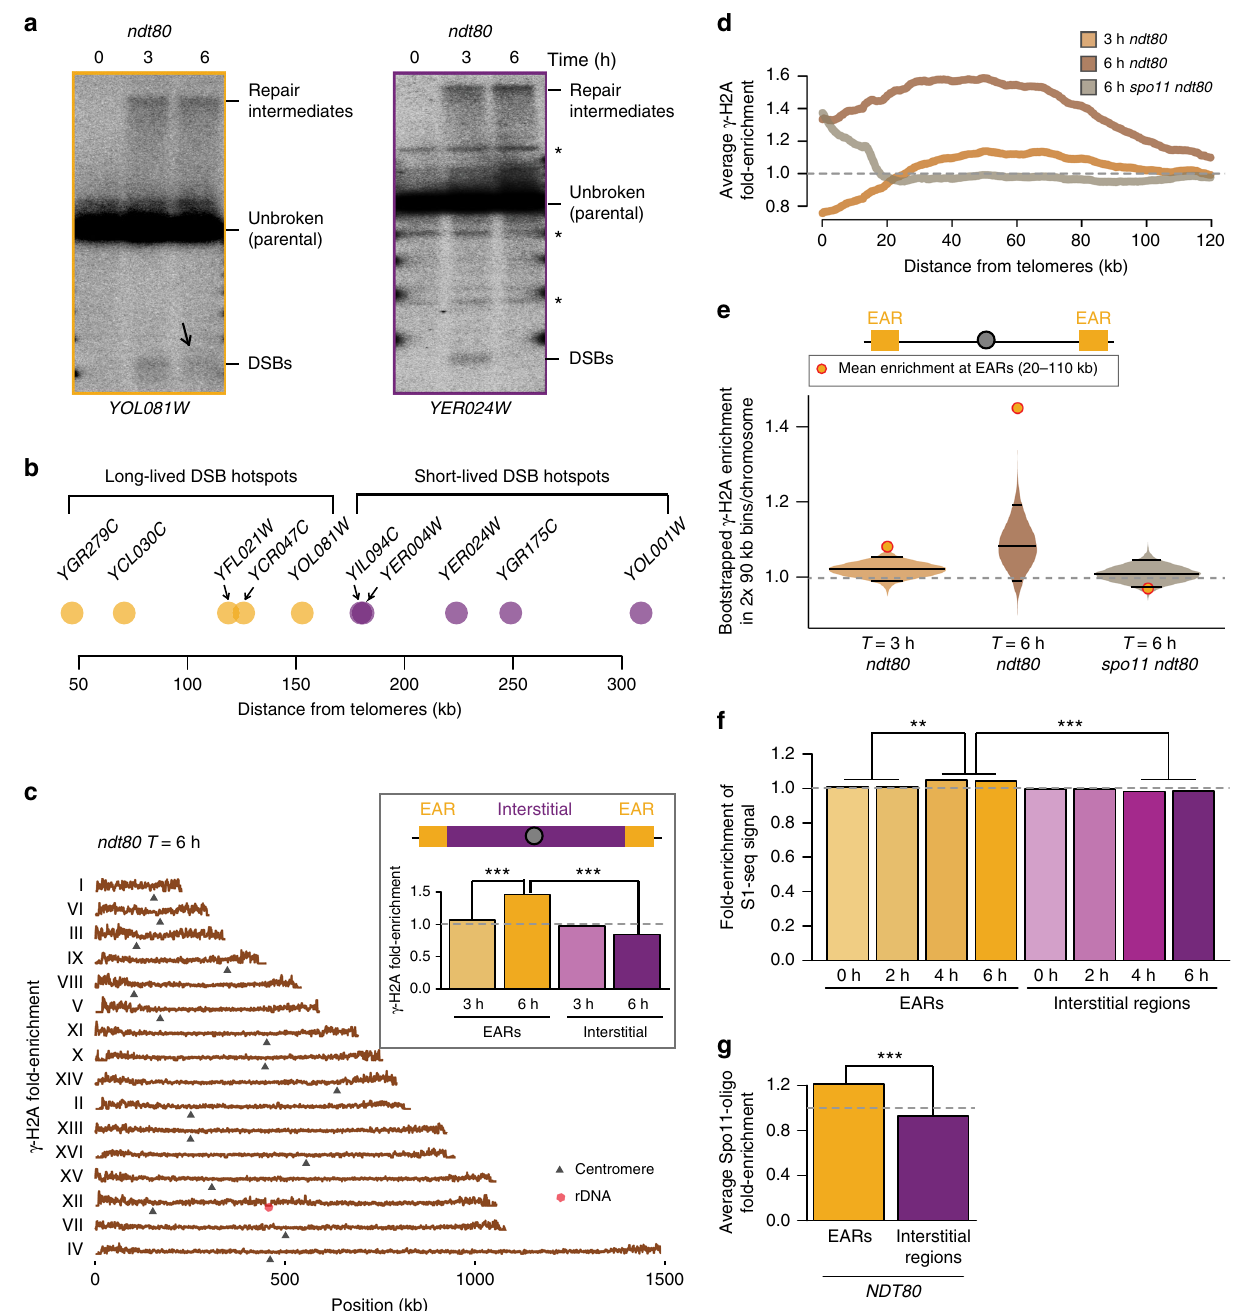
Fig. 1 Long-lived DSB hotspots occur primarily in EARs. a Southern analysis of DSBs from ndt80 Δ cells progressing synchronously though meiotic prophase at YOL081W (long-lived DSB hotspot, orange outline) and YER024W (short-lived DSB hotspot, magenta outline). Black arrow highlights continued DSBs in late prophase ( T = 6 h) at the YOL081W hotspot. Asterisk (*) denotes nonspeci fi c bands. b Distance of queried DSB hotspots (orange, long-lived; magenta, short-lived) from their closest telomere ( 11,23,31 ; this manuscript). c γ -H2A ChIP-seq enrichment is plotted along each of the 16 yeast chromosomes; black triangles mark the centromeres and the red hexagon marks the rDNA locus. The data are normalized to a global mean of 1. Inset shows mean enrichment at EARs (20 – 110 kb from telomeres; orange) and interstitial chromosomal regions (>110 kb from telomeres; magenta) in early prophase ( T = 3 h) and extended prophase ( T = 6 h). *** P < 0.001, Mann-Whitney-Wilcoxon test. d Mean γ -H2A enrichment in the EARs (32 domains) is plotted as a function of distance from telomeres. e Bootstrap-derived distributions within two 90-kb bins per chromosome from ChIP-seq data are shown as violin plots. Lower and upper quantile (95% CI), as well as the median computed from the bootstrap data are depicted as horizontal lines. The orange/red dot shows the mean ChIP-seq enrichment in EARs (20 – 110 kb) for the respective samples. Divergence of the boot-strap derived median from the genome average is the result of data structure and large bin sizes. f Time series of S1-seq signal re fl ecting resected DSB ends 43 are normalized to genome average and plotted as mean signal in EARs (20 – 110 kb, 32 domains) and interstitial chromosomal regions (>110 kb from either end of all chromosomes, 16 domains). *** P < 0.001 and ** P < 0.01, ANOVA on mean enrichment followed by a post-hoc Tukey test. g Spo11-oligos within hotspots 16,44 are normalized to genome average and plotted as mean signal in EARs (20 – 110 kb, 32 domains) and interstitial chromosomal regions (>110 kb from either end of all chromosomes, 16 domains). *** P < 0.001, ANOVA on mean enrichment followed by a post-hoc Tukey test. The gray dashed line in c – g is the genome